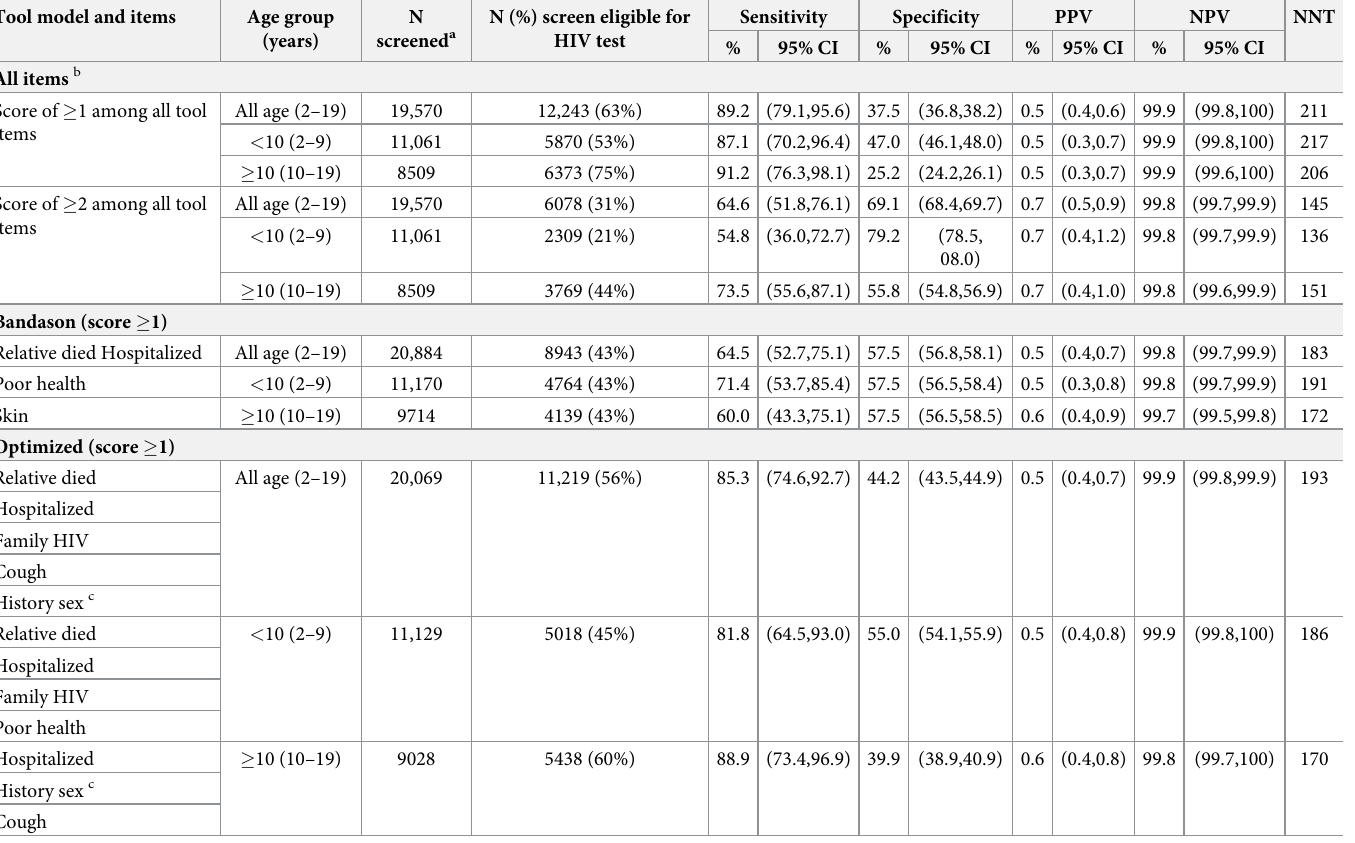
Table 3. Validation measures for different risk screening tool options, by age